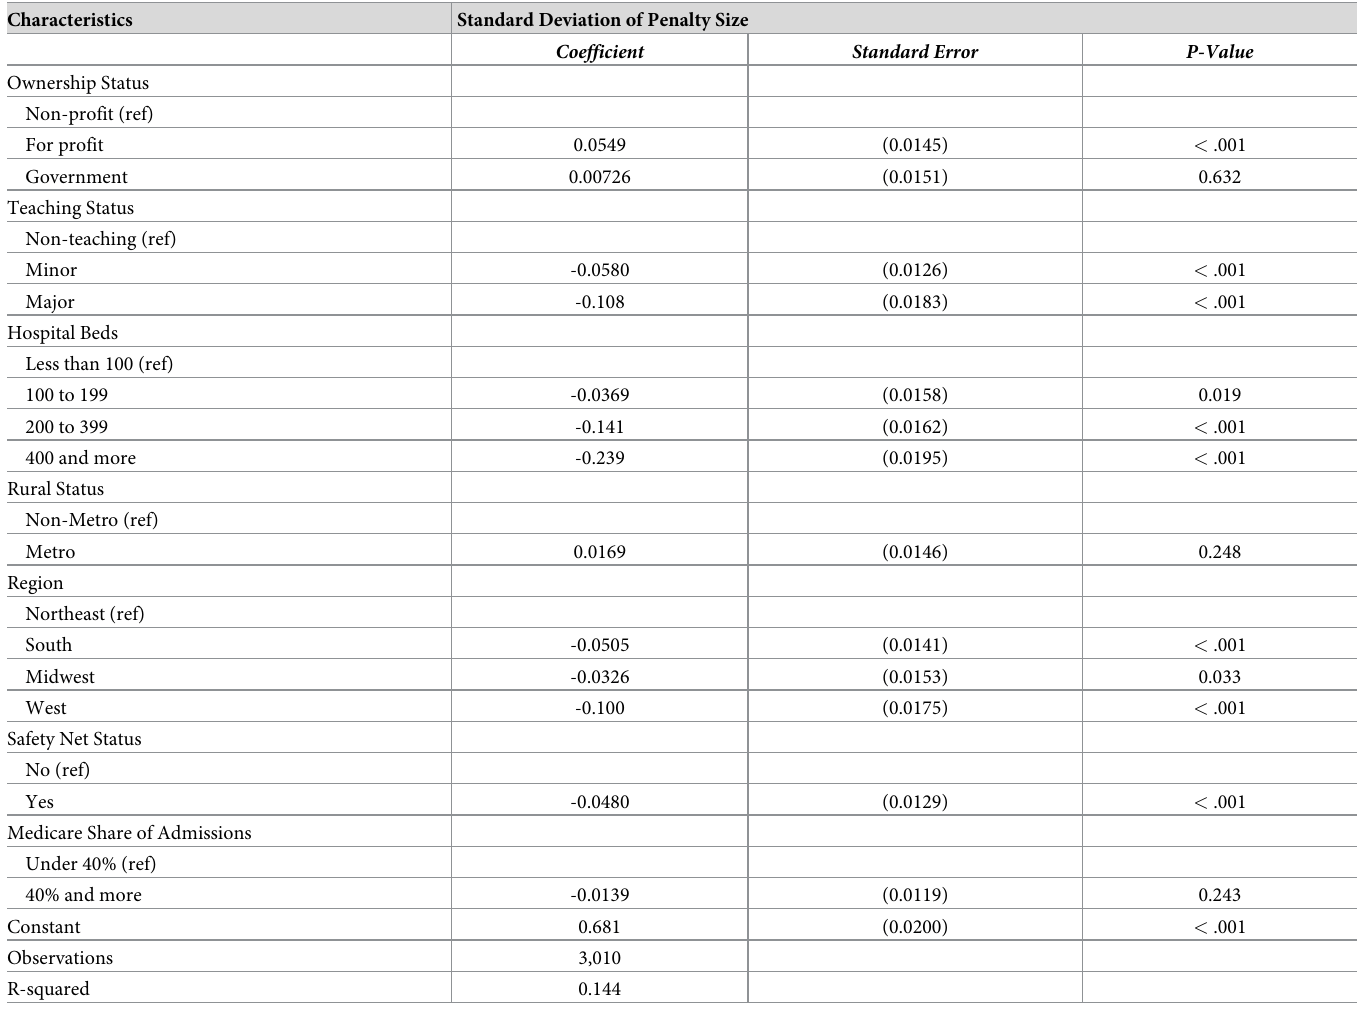
Table 4. Misclassification and measure of dispersion of penalty size, shown by hospital characteristics.